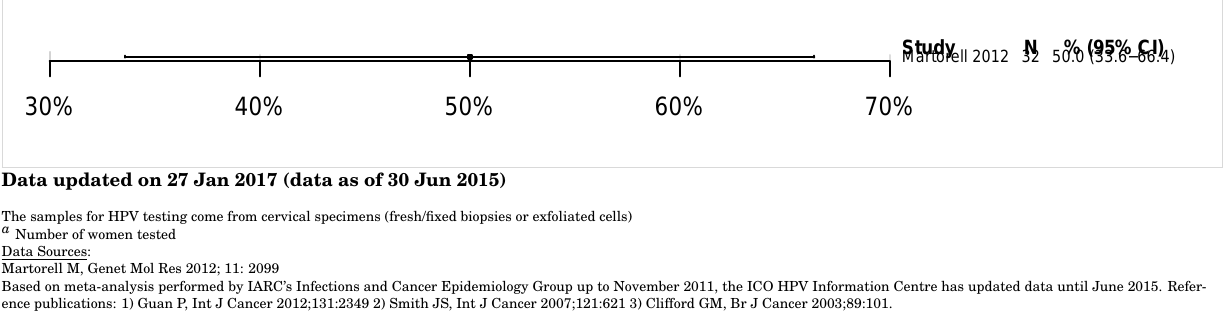
Figure 58: HPV 16 prevalence among women with high-grade cervical lesions in Peru, by